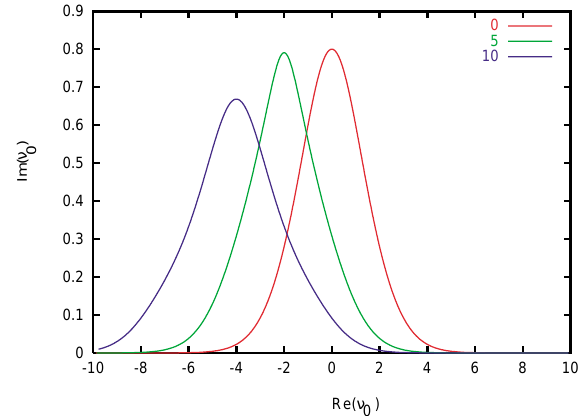
FIG. 7. (Color) Threshold diagrams for ten-term Gaussian series for k (cid:1) 0, 5, 10 with q (cid:6) k (cid:1) 3 (cid:6) 5 .